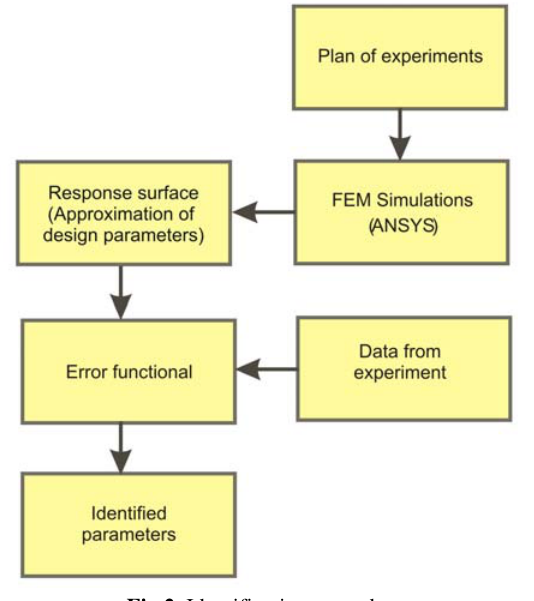
Fig 2. Identification procedure